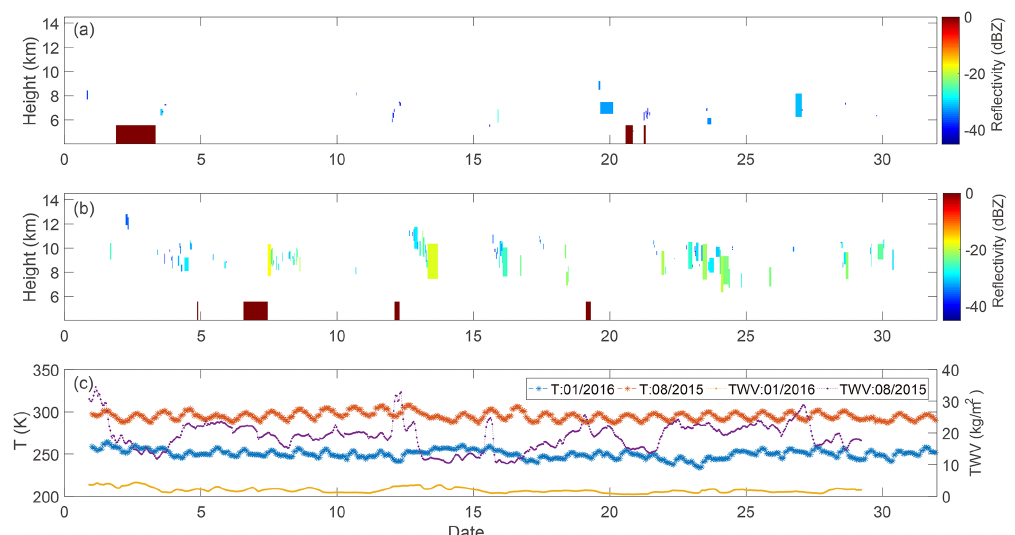
Figure 1. Ice clouds occurring in (a) January 2016 (winter) and (b) August 2015 (summer). The mean cloud-top height, mean base height and lifetime of each ice cluster forms an ice cloud “rectangle”. Its mean radar reflectivity is illustrated with different colors. Dark red rectangles on the horizontal axis indicate periods without vertically pointing radar measurements. The surface temperature ( T ; left-hand y axis) and total water vapor (TWV; right-hand y axis) in the 2 months are presented in panel (c)